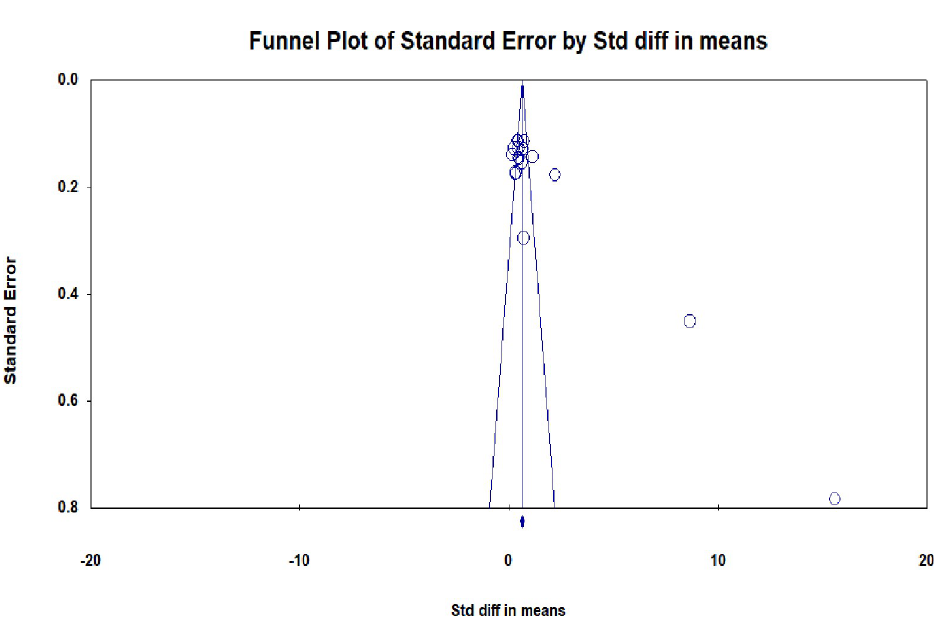
Fig 5. Funnel plot of BL versus traditional teaching in improving knowledge.